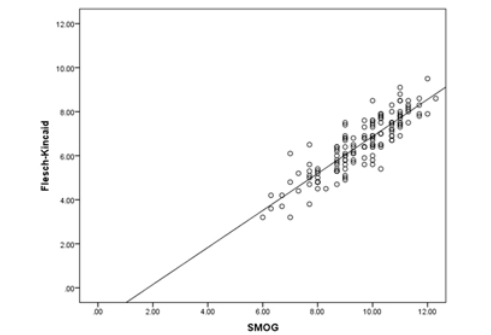
Figure 3 Scatterplot of